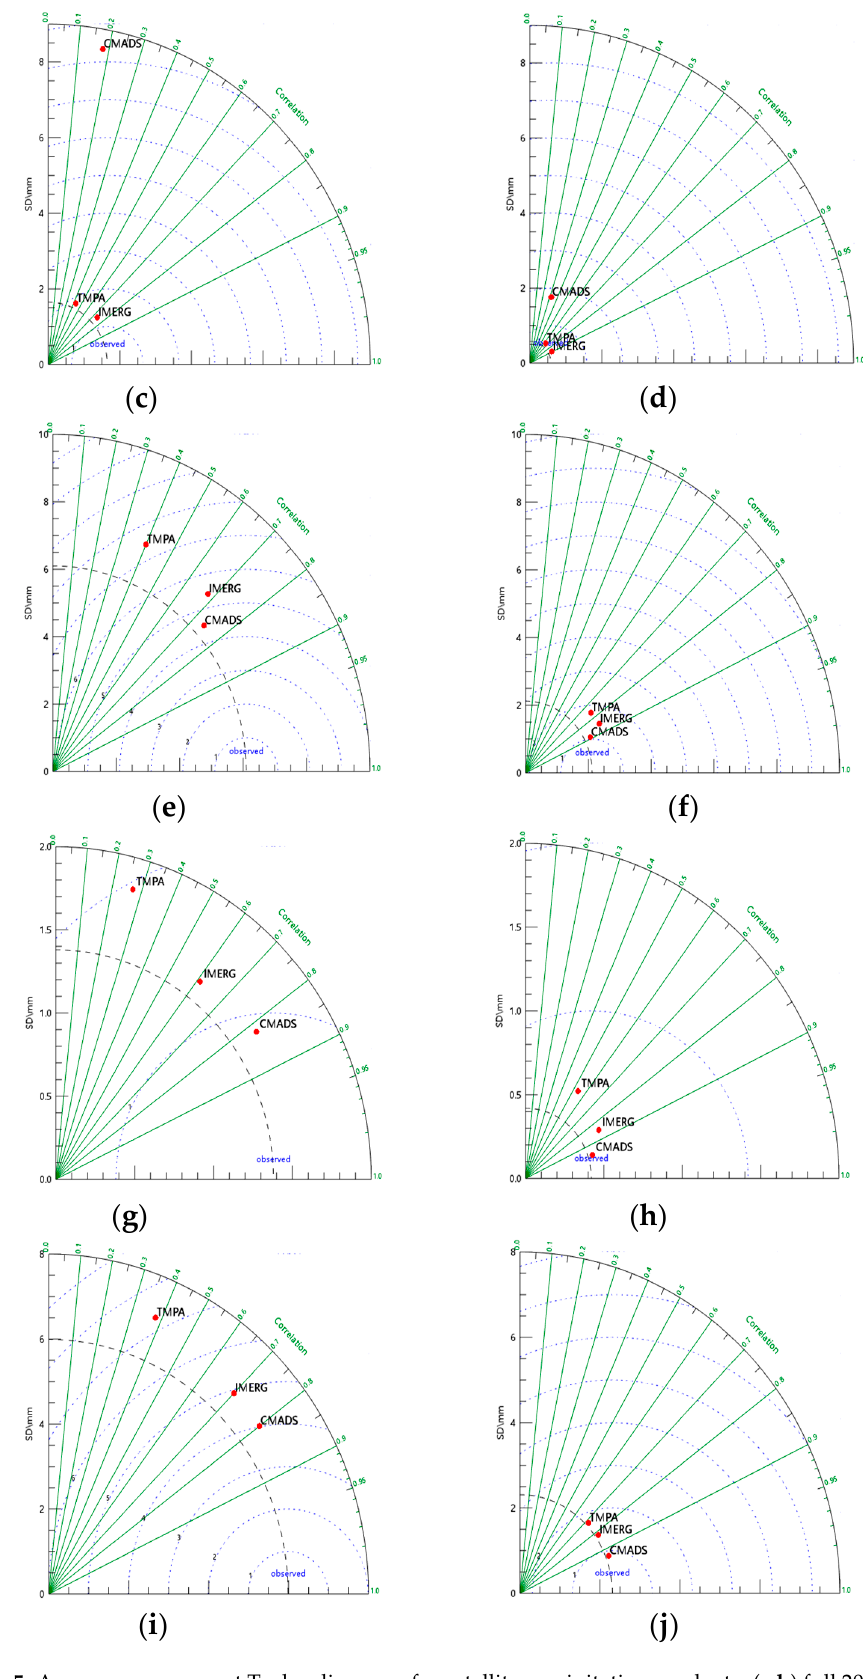
Figure 5. Accuracy assessment Taylor diagrams for satellite precipitation products: ( a , b ) full 2014–2016 cycle; ( c , d ) first dry season; ( e , f ) first rainy season; ( g , h ) second dry season; ( i , j ) second rainy